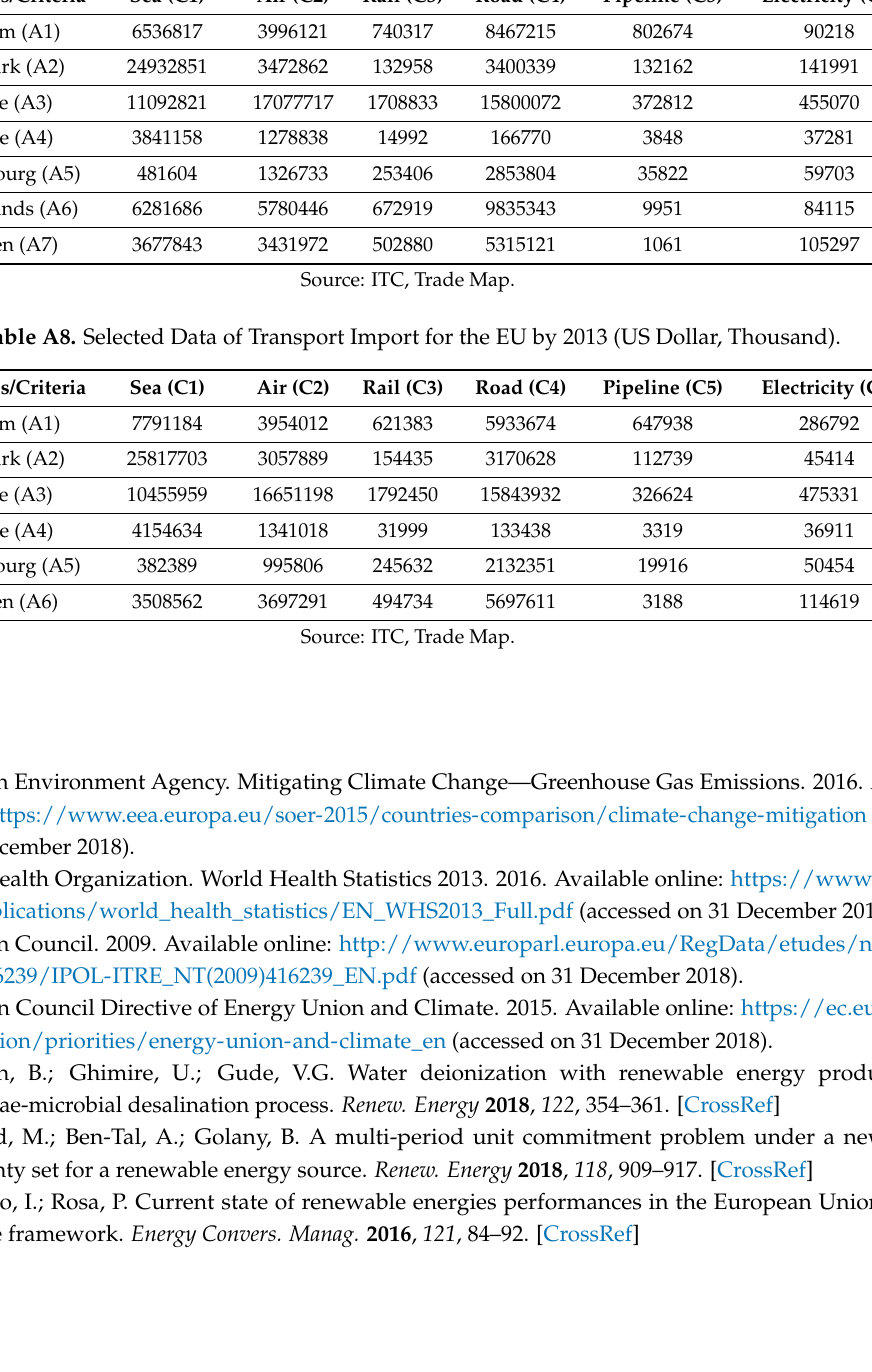
Table A7. Selected Data of Transport Import for the EU by 2014 (US Dollar, Thousand). Countries/Criteria